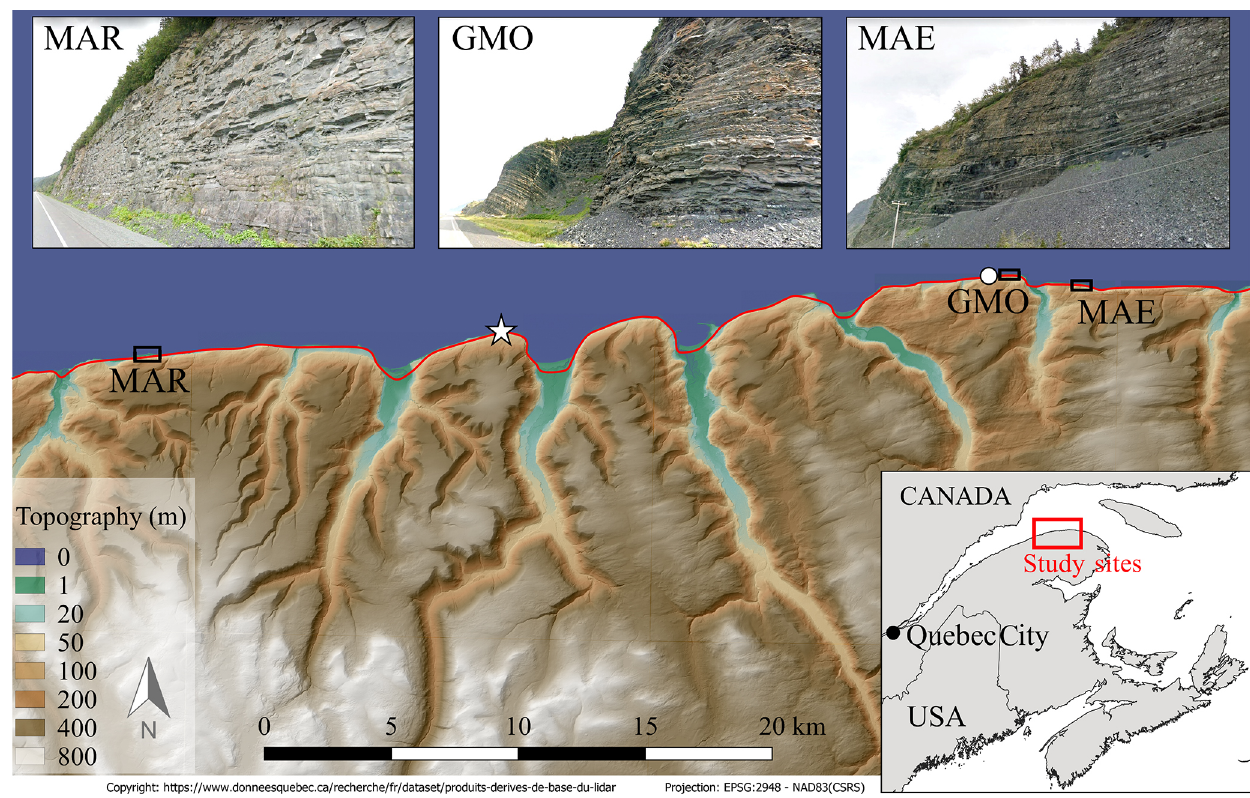
Figure 1. Location of the three study sites (MAR, GMO, MAE), of the rain and snow gauge (white star), and of the thermistor strings that measured the temperature to a depth of 550cm (white circle). The red line is for the exposed-to-rockfalls Route